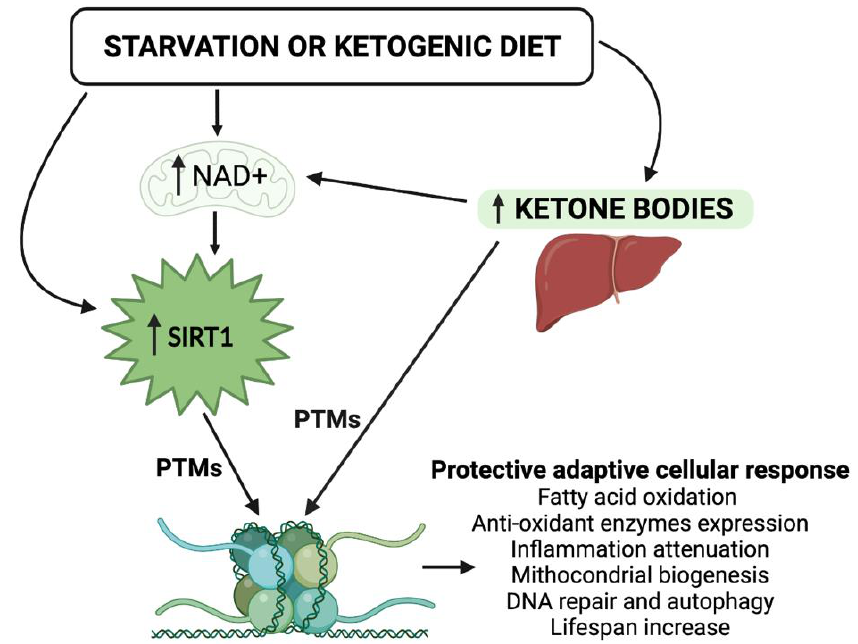
Figure 1. Schematic representation of the epigenetic activity of ketone bodies and SIRT1 in response to starvation or to the ketogenic diet. Synergistically, KBs and SIRT1 target both histone and nonhistone proteins and alter cellular metabolic programs. NAD, nicotinamide adenine dinucleotide; PTMs, post-translational modifications.